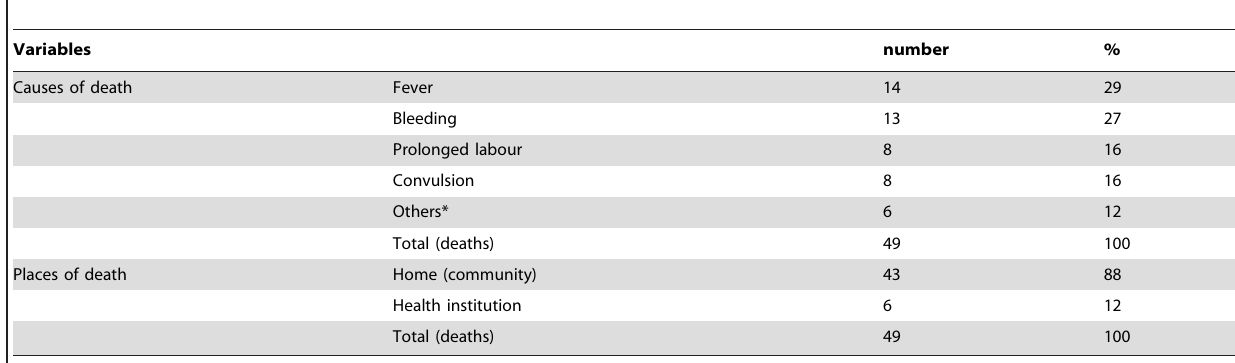
Table 3. Causes and places of maternal deaths, Bonke, Gamo Gofa, south-west Ethiopia, 2006–2010.